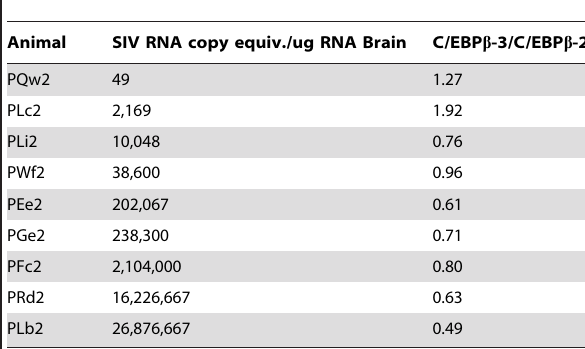
Table 4. SIV RNA and Ratio of C/EBP b -3/C/EBP b -2 in SIV- infected Macaque Brain at 42 Days